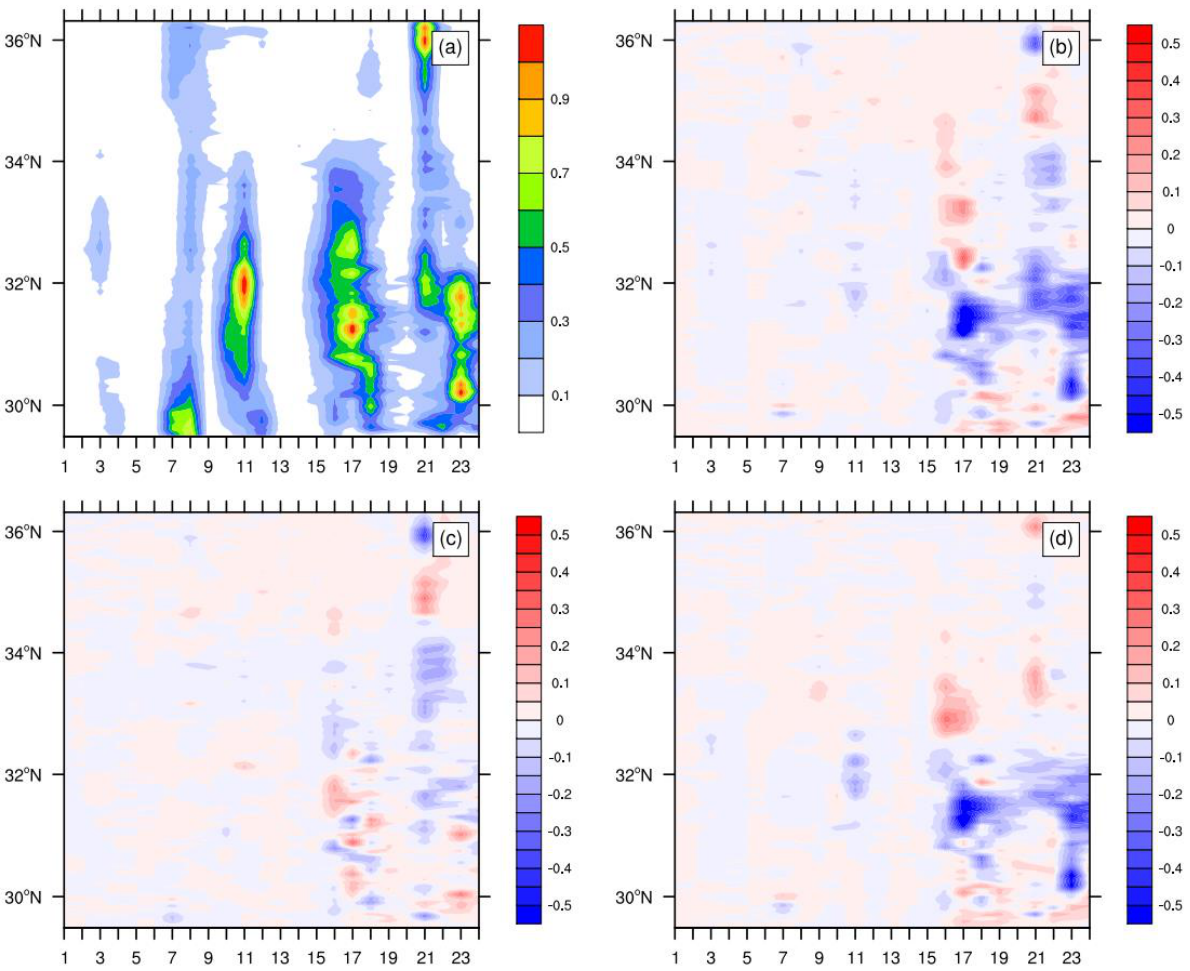
Figure 6. Diurnal-latitude diagrams, where diurnal-latitude diagrams of daily accumulated precipitation (mm) averaged in domain 3 in CTRL ( a ). Panels ( b – d ) are the differences ( b ) between LowQD and CTRL (LowQD minus CTRL), ( c ) between LowQ and CTRL (LowQ minus CTRL), as well as ( d ) between LowD and CTRL (LowD minus CTRL), respectively. Blue (red) shading indicates negative (positive) variation. The diurnal Universal Time Coordinated (UTC) is used.